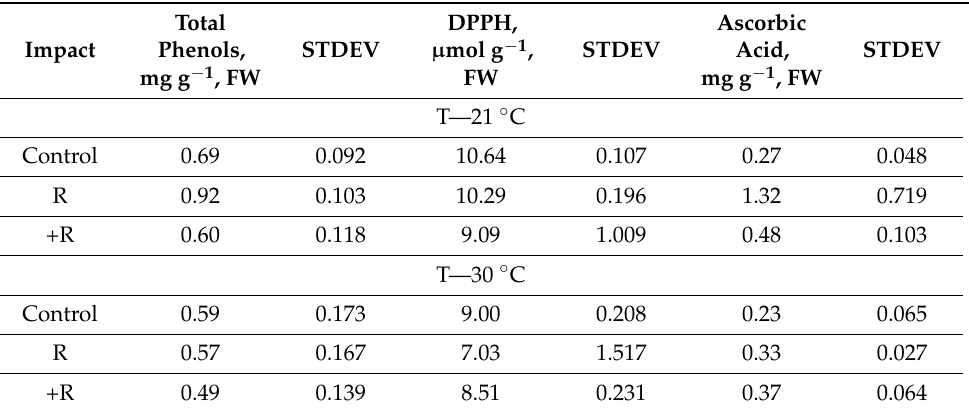
Table 4. Changes of antioxidant properties of tomato cultivated under combinations of different temperatures and HPM radiation. Total Impact